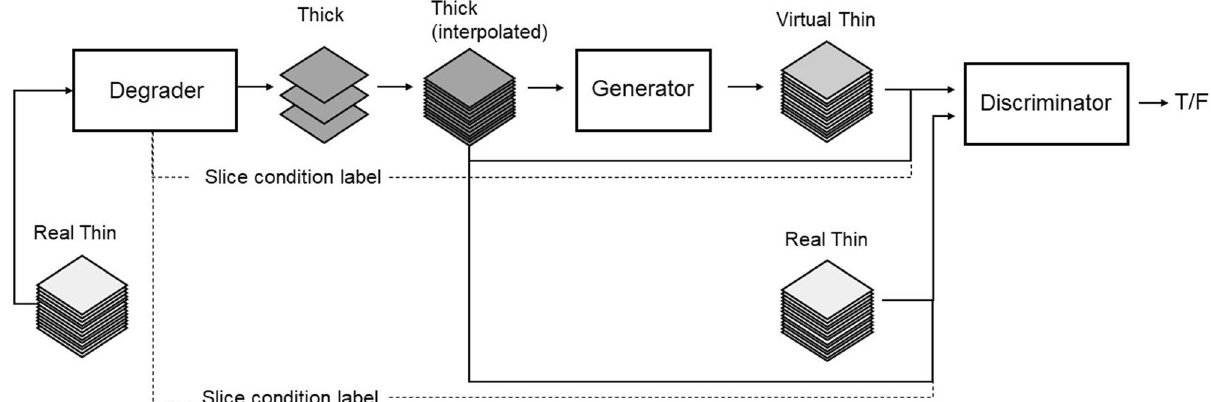
Figure 1. Adversarial training framework for thick–thin slice translation of CT